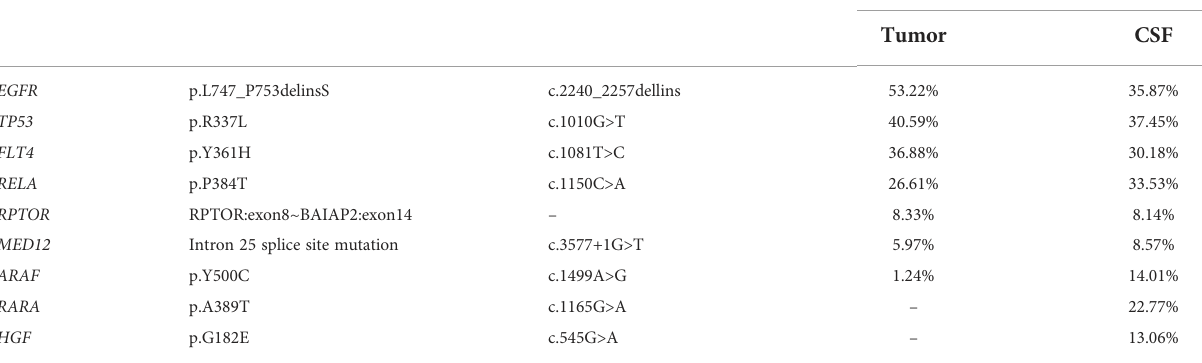
TABLE 1 Genetic alterations identi fi ed in the biopsies.